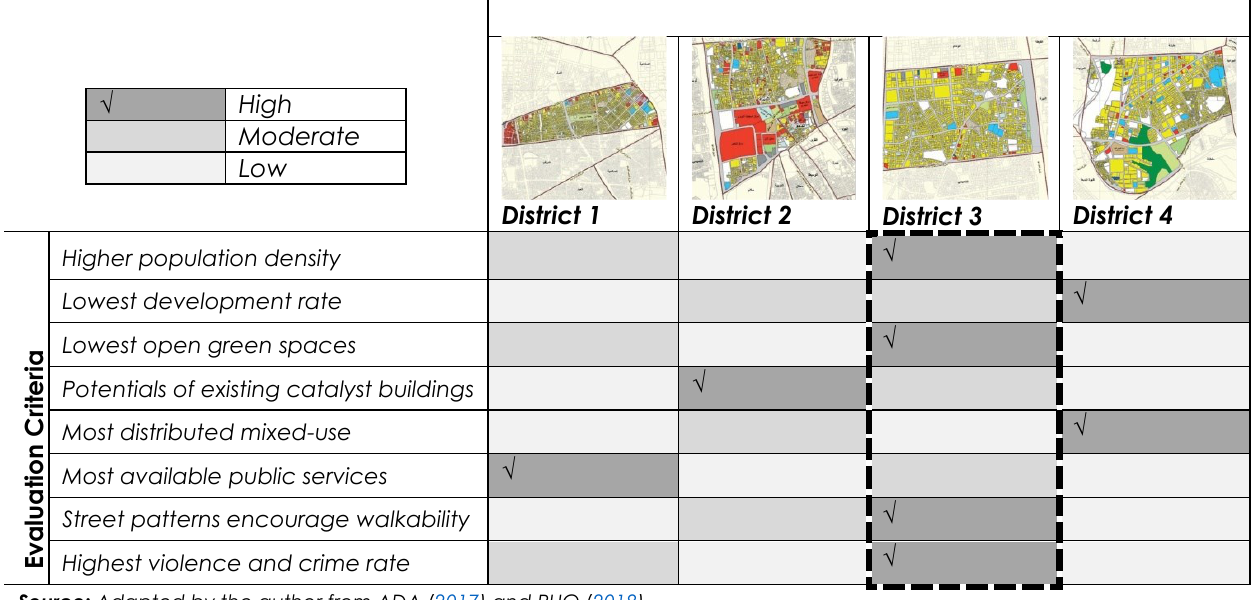
Table 8. Evaluating the four districts to select the best one Selected Zones.